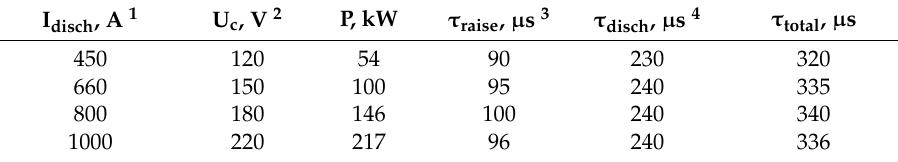
Table 1. Electric parameters of the experimental setup corresponding to different current regimes (per pulse). I disch , A 1 U c , V